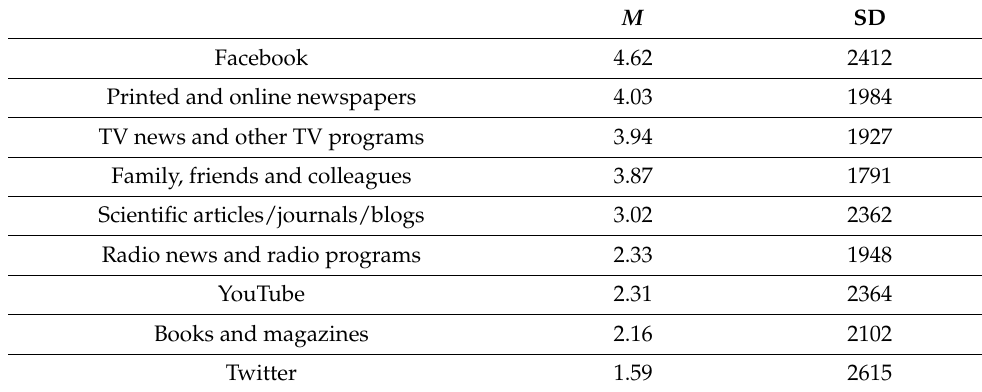
Table 1. Source of Information about climate change ( n = 312).